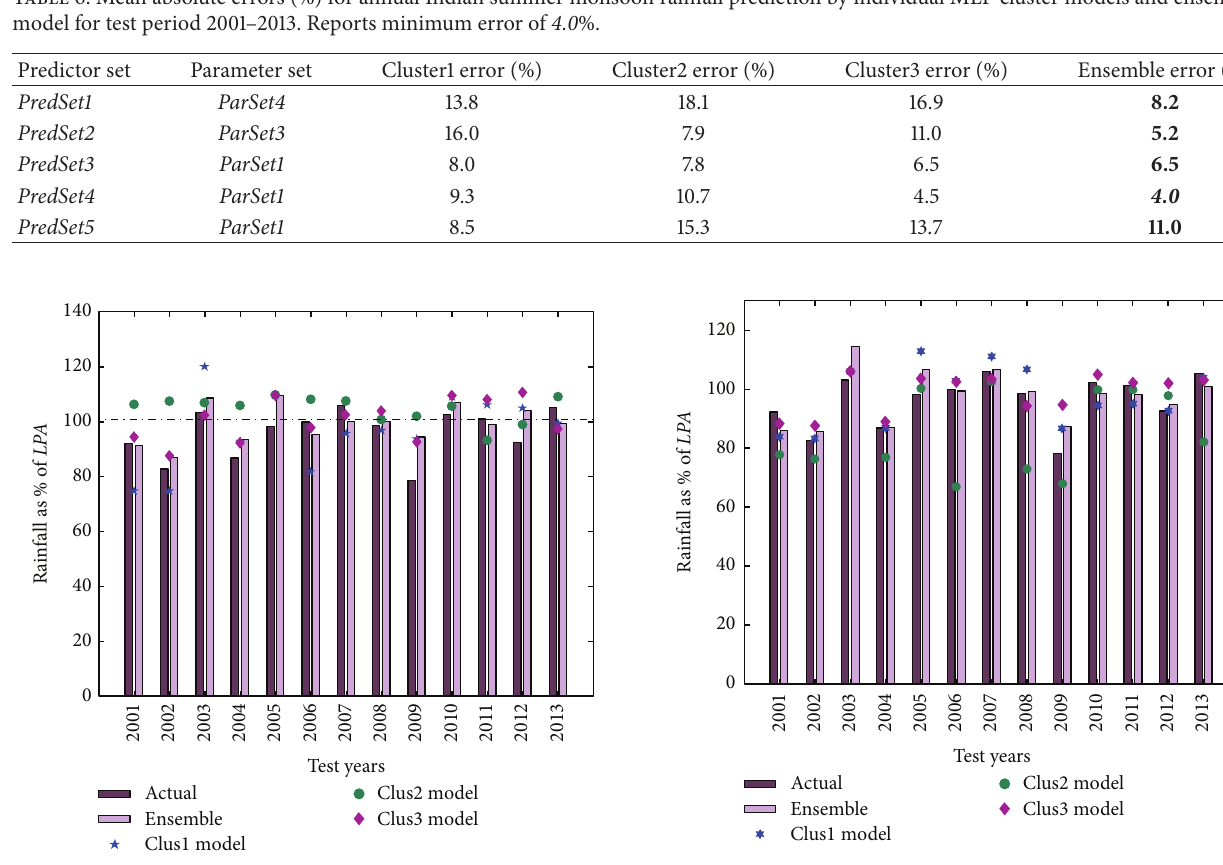
Figure 4: Performance of forecasts by proposed fuzzy clustering- based ensemble model and its respective three clusters models by MLP for PredSet4 . The deep and light purple bars represent the actual and predicted ISMR in terms of percent of LPA . The symbols represent forecasts given by individual cluster models. The results are shown for test period